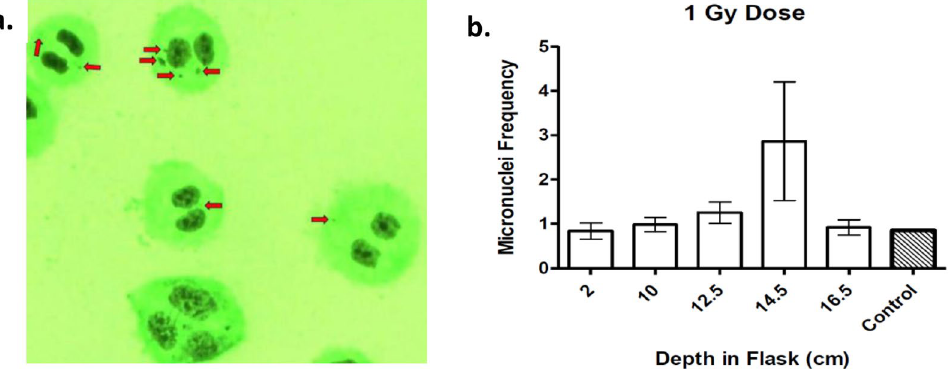
Figure 5. Micronuclei frequency at increasing depths in T-175 flasks. ( a ) Example of evaluated micronuclei formation. Red arrows indicate micronuclei evaluated from binucleated cells. ( b ) Micronuclei frequency observed to be highest at depth of 14.5 cm. Error bars indicate standard errors of the means from as many as three independent irradiation experiments, as well as, for our